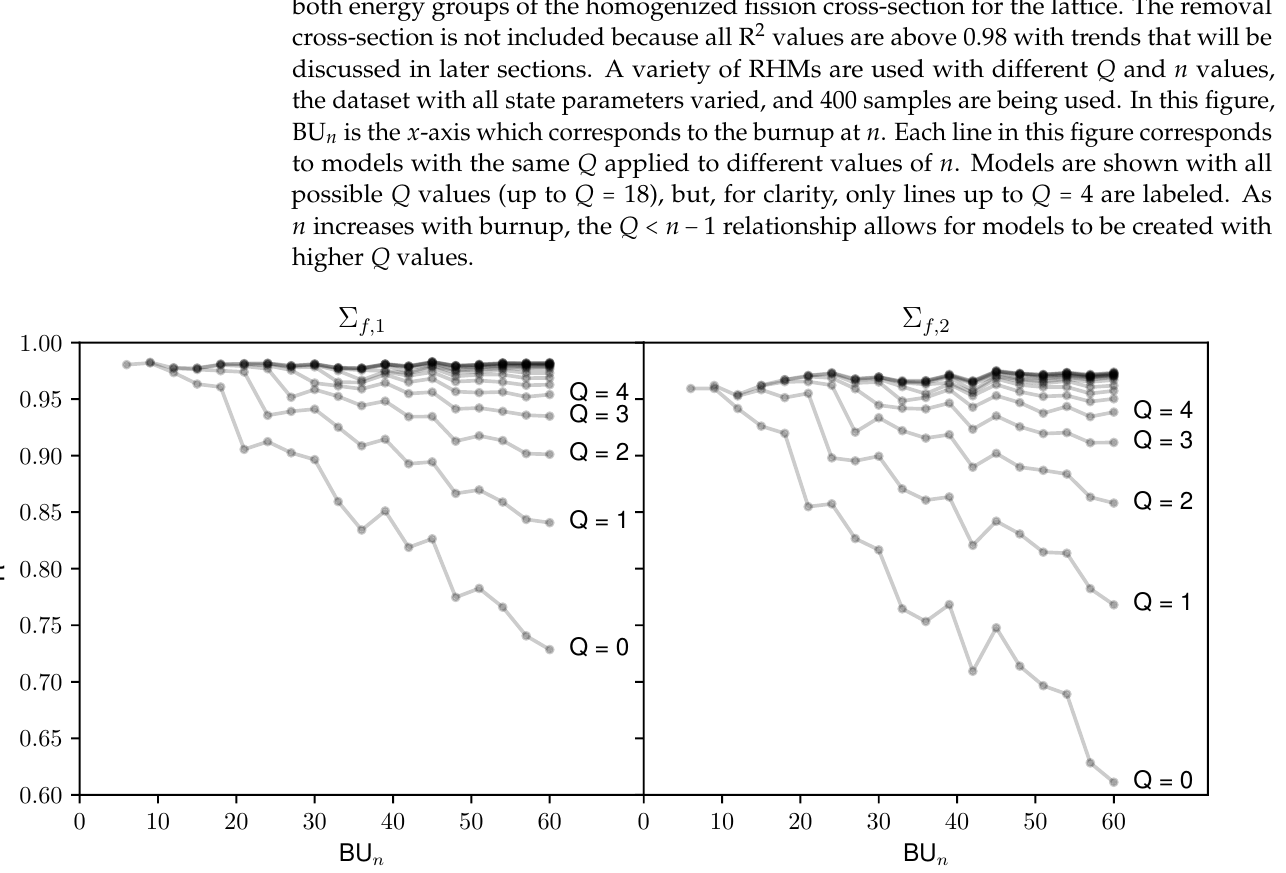
Figure 4. Coefficient of determination for varying Q values when fitting the RHM to the relationship between all state variables and fission HXS over all